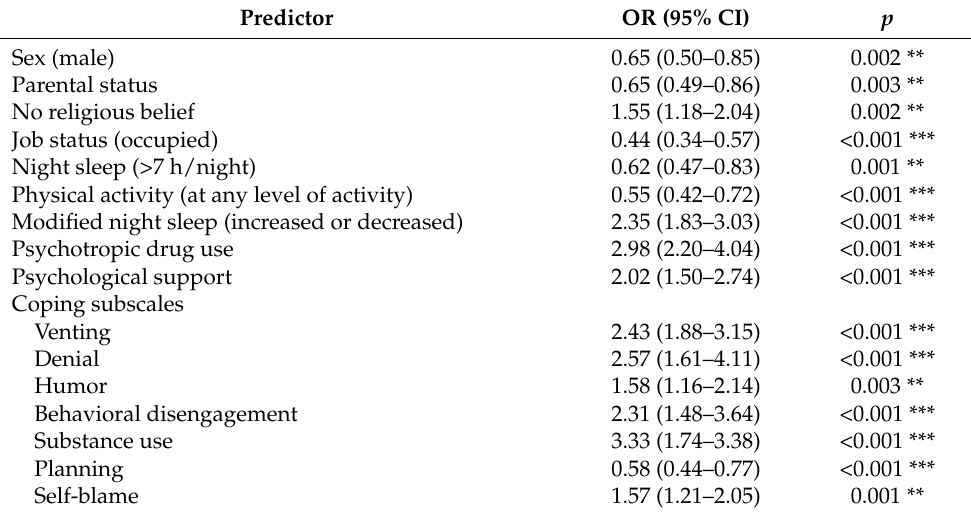
Table 5. Multivariate logistic regression analysis of factors associated with depression at PHQ-9 (Total score > 10, at least 5 items ≥ 2, and item 1 or 2 ≥